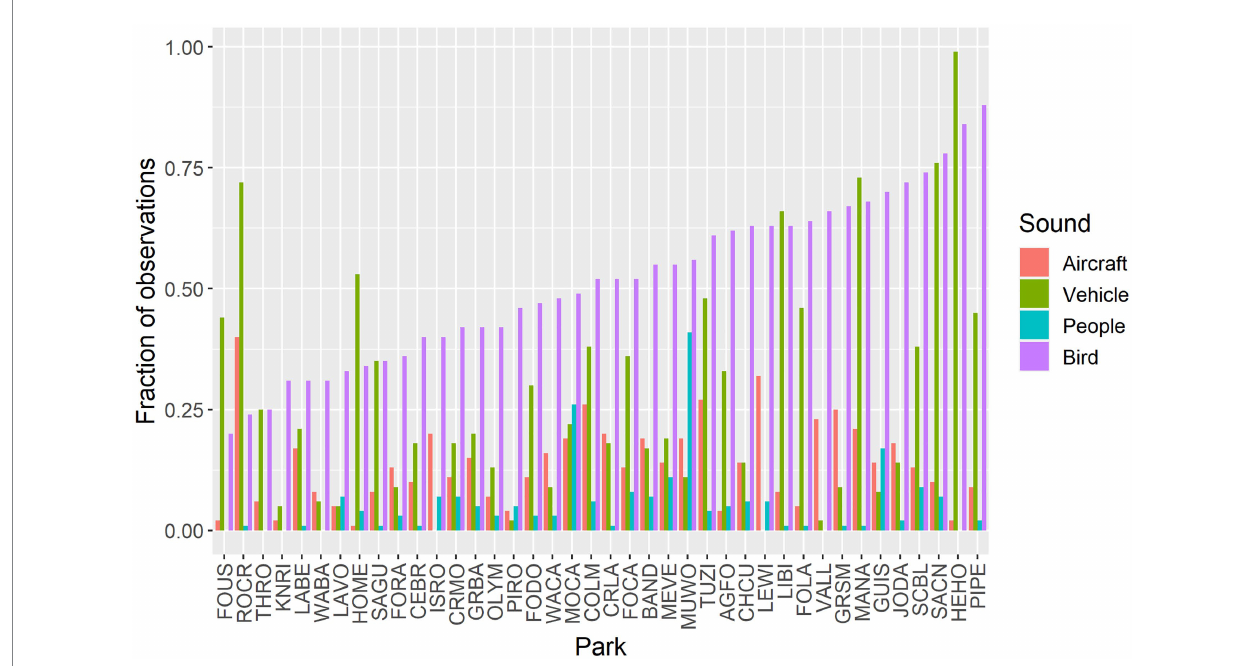
FIGURE 2 Fractions of observations with each sound, by park, ordered by bird